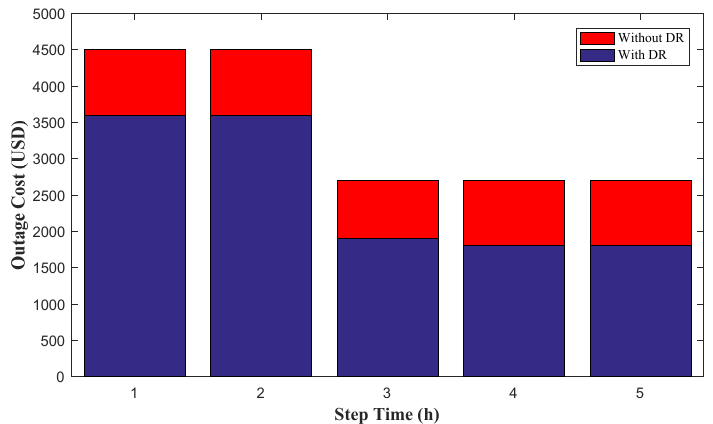
Figure 13. The effect of the EDRP on the outage cost in the 66 bus case. Figure 13. The e ff ect of the EDRP on the outage cost in the 66 bus